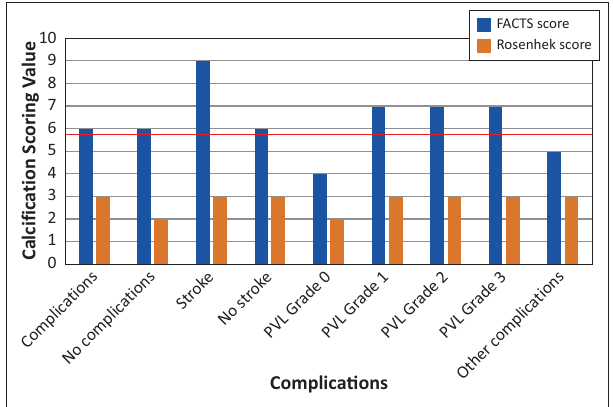
TABLE 2: Patient demographics.